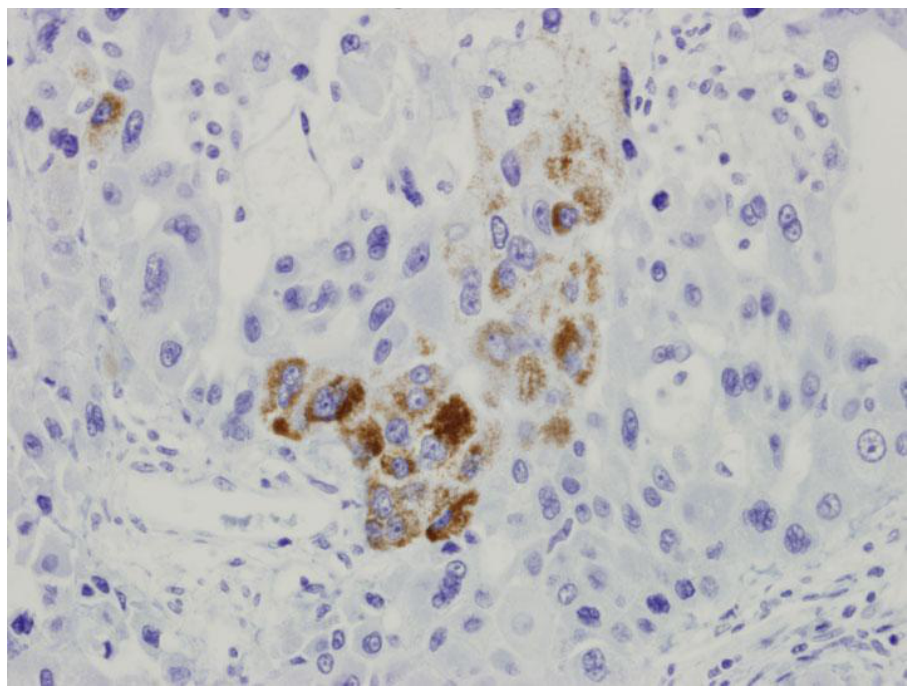
FIGURE 6. Hepar immunostain positive in tumor cells, confirming the diagnosis of